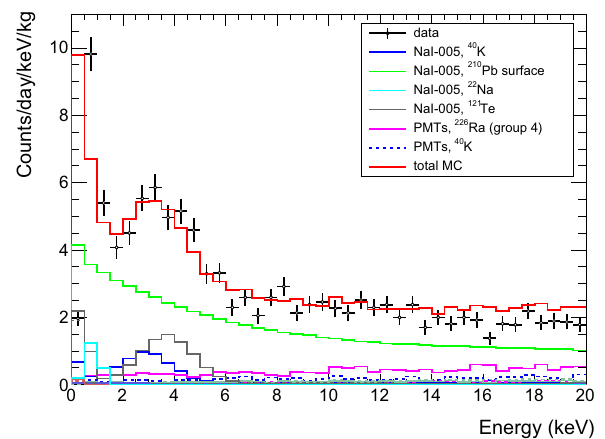
Fig. 8 Comparison of data and Monte Carlo simulation of the low- energy background spectra